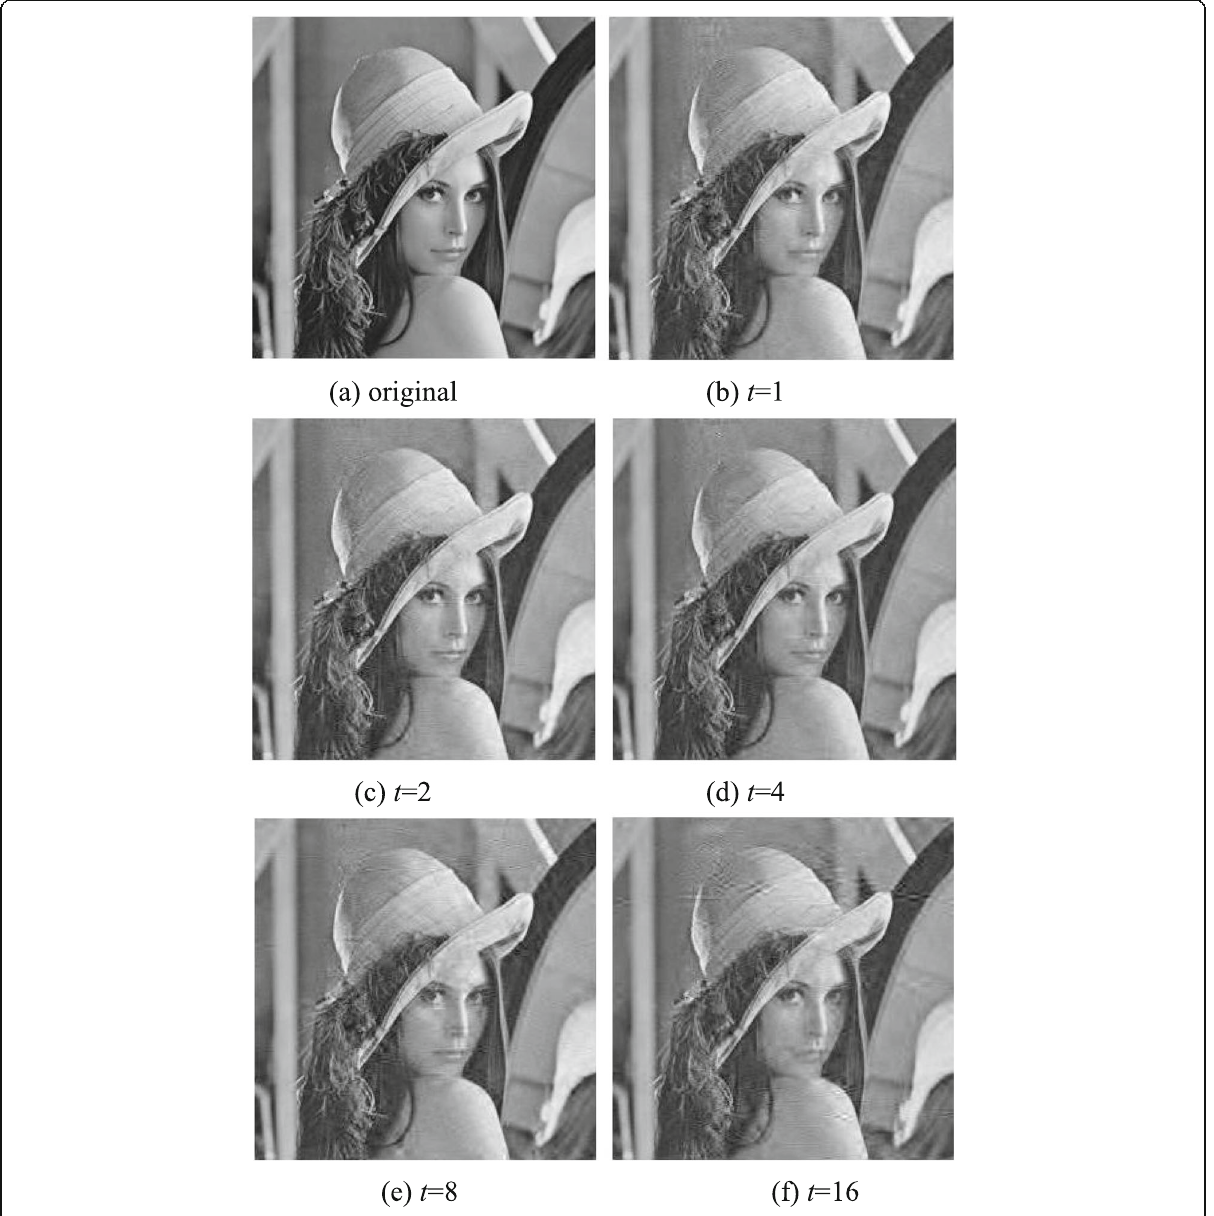
Fig. 4 Comparison of the reconstructed images with different dimensions of measurement matrices. (Lena, M = 128, N = 256, ℓ 0 -minimization with ρ = 0.8). Frame a is the original image; Frame b is the reconstructed image from the original in Frame a using the matrix Φ 128×256 ; Frame c is the reconstructed image using the matrix Φ 64×128 ; Frame d is the reconstructed image using the matrix Φ 32×64 ; Frame e is the reconstructed image using the matrix Φ 16×32 ; Frame f is the reconstructed image using the matrix Φ